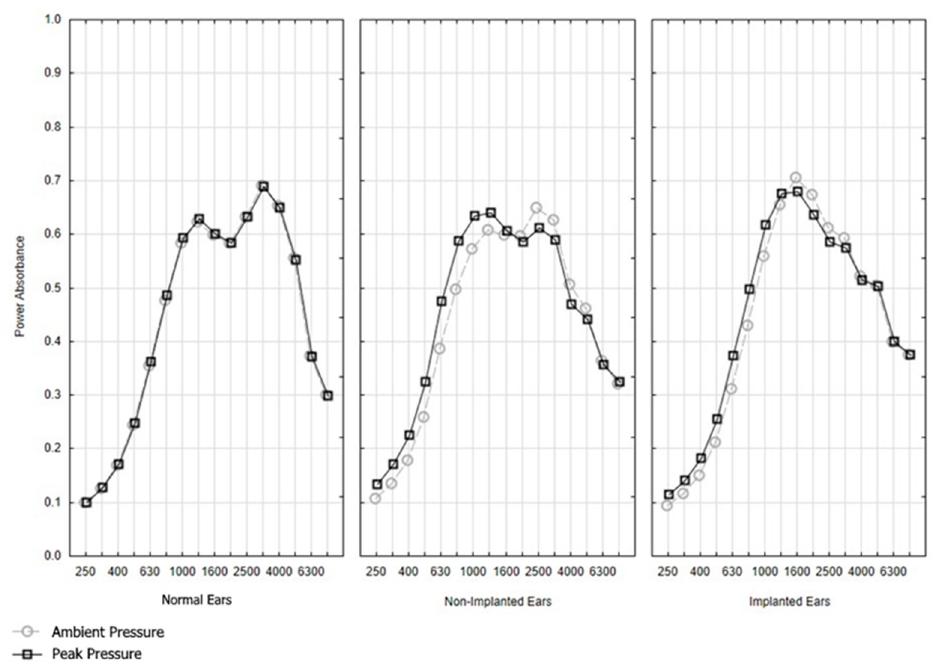
Figure 4. Absorbance per frequency for the ambient and pressure setting for the three study conditions: normal-hearing ears (n = 48); non-implanted ears of only the unilaterally implanted CI participants (n = 15); and implanted ears, including two bilaterally implanted CI participants (n = 17).